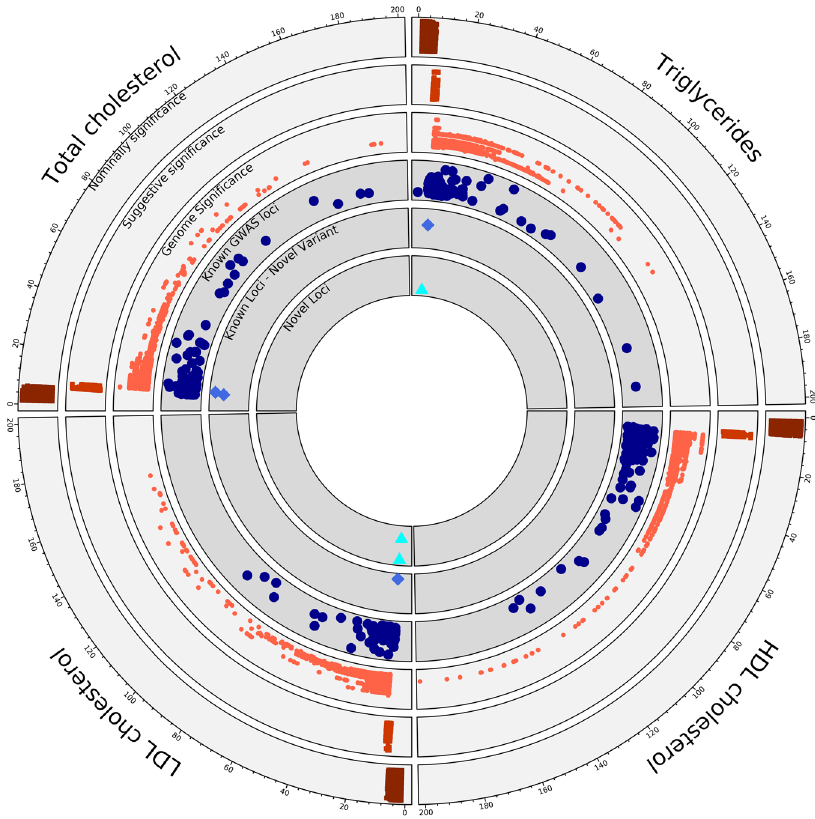
Fig. 2 | Summary of single variant genome-wide association. Representation of the single variant GWAS results from TOPMed Freeze 8 whole genome sequenced data of 66,329 samples. Each quarter represents a different lipid phenotype, and dotsextendinginclock-wisefashionrepresentvariantswithincreasingevidenceof association as noted by − log10( p -value), which was truncated at 200. The outer three circles show the GWAS data from TOPMed freeze8 where variants binned to nominally signi fi cant ( p -value 0.05 – 5×10 − 07 ), suggestive signi fi cant ( p -value 5×10 − 07 – 5×10 − 09 )andgenomewidesigni fi cant( p -value<5×10 − 09